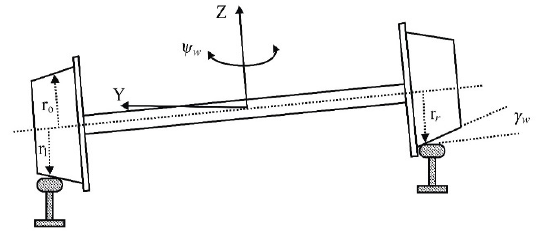
Fig. 2: Railway Wheelset Lateral Displacement